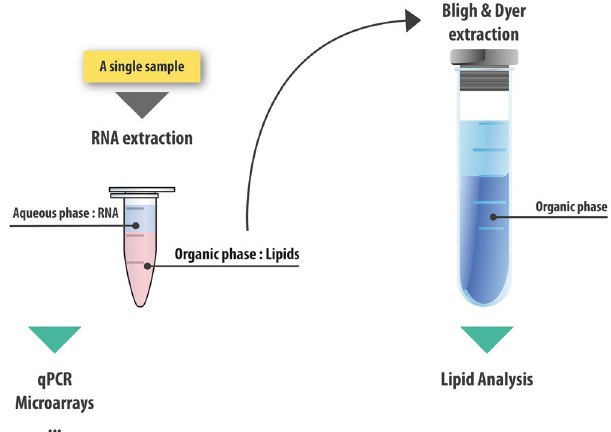
Figure 7. Dual extraction of lipid and mRNA from a single